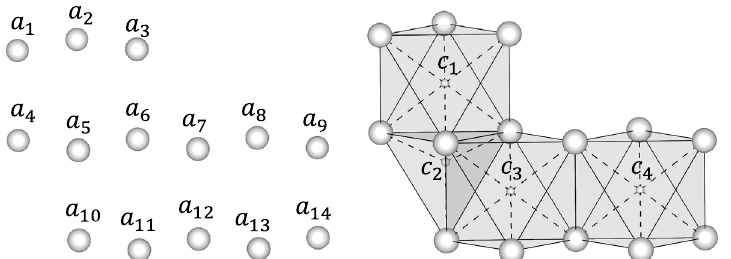
Fig. 2 Details of structural mapping in Li-Mn-O-F rocksalt system. a Example of Li + (green sphere) and its anion polyhedra in relaxed DFT structure which cannot be mapped to its proper cation site (white sphere), but which can be mapped using the new mapping technique. b Diagram of new structure mapping process, which involves mapping the anions ( a i ) of the relaxed structure s relaxed to the anion sites of the lattice con fi guration s lattice (left), followed by mapping the cations of s relaxed to the proper cation sites in s lattice by matching the anions in their anion polyhedra. c Example structure which fails to map using new mapping technique due to an Mn 2 + that has relaxed too far from one of the O 2 − anions in its anion